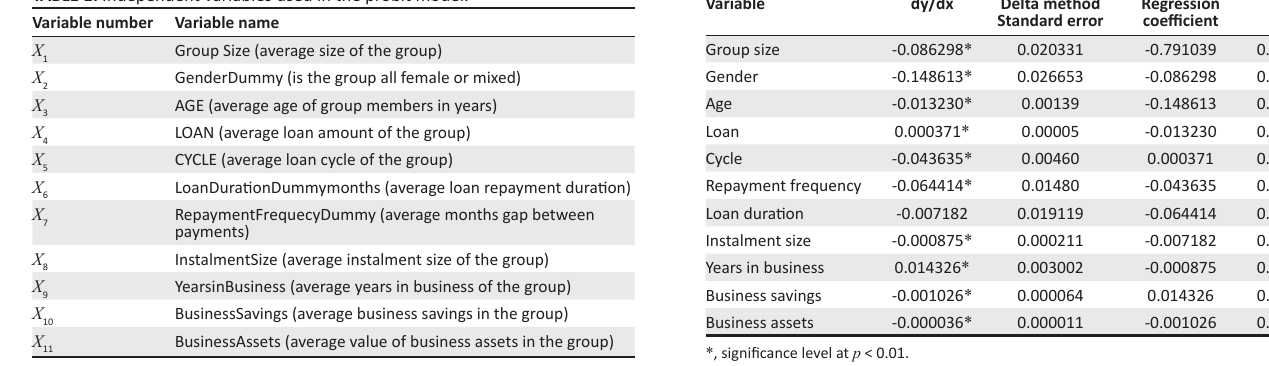
TABLE 1: Independent variables used in the probit model. Variable number Variable name